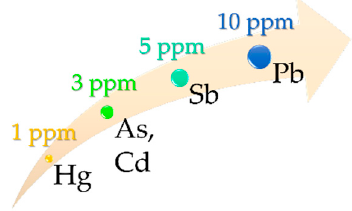
Figure 1. Acceptable limits for heavy metals in topical products [39].